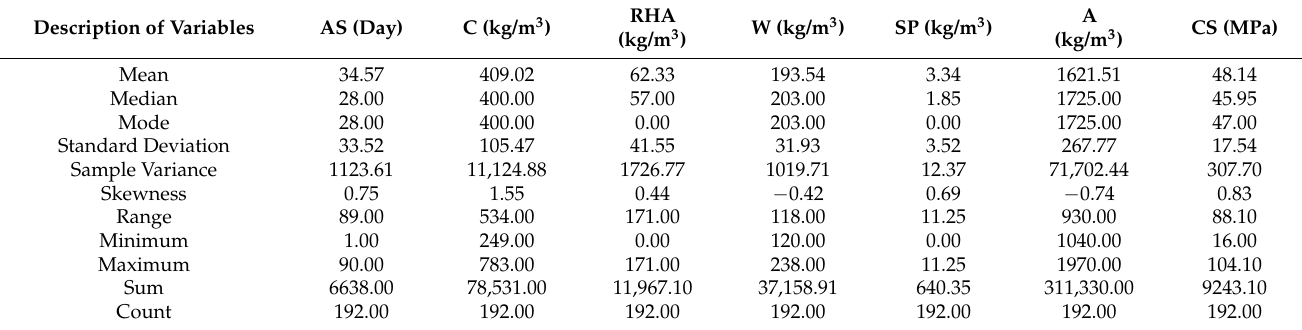
Table 2. Statistical description of